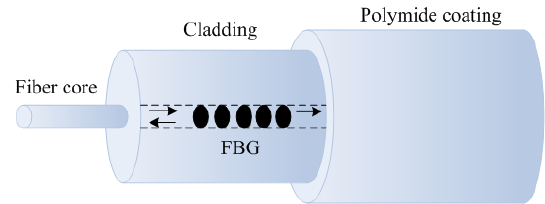
Fig. 1 Structure of the FBG written in a polymide coated optical